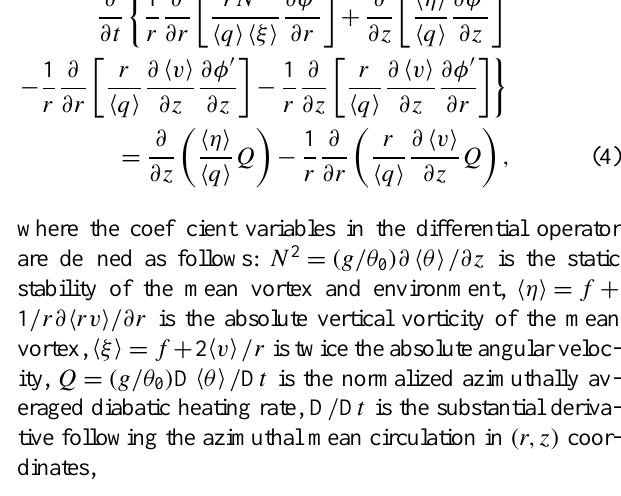
Fig. 7. The maximum azimuthally-averaged heating rate from the 3D3k (red) and AX3k (blue) simulations plotted against instanta- neous intensity (e.g., Fig. 1.